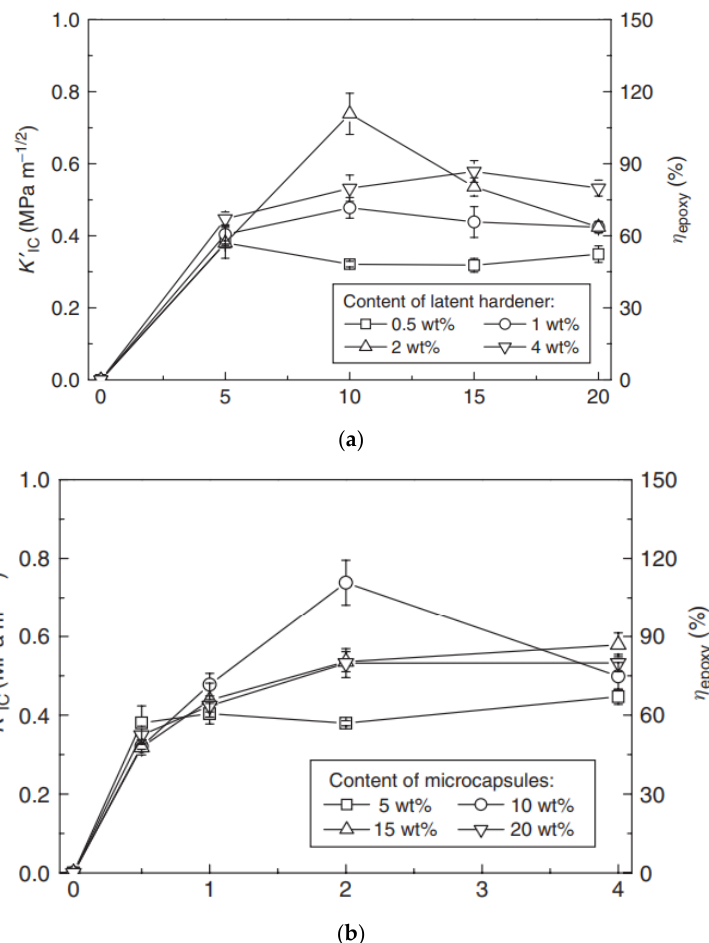
Figure 21. Self-healing ability of epoxy-based on different contents: ( a ) latent hardener and ( b ) microcapsules [6].